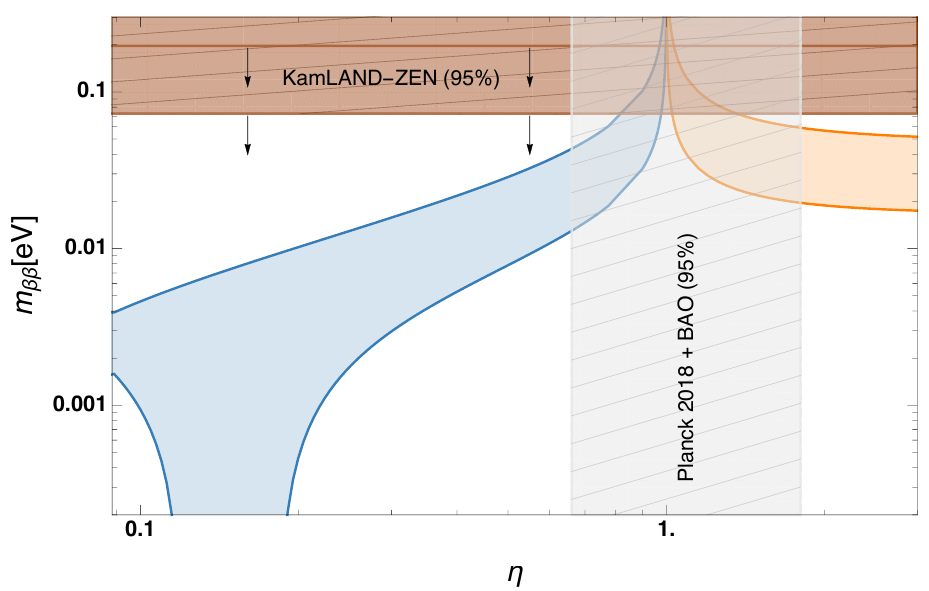
Figure 6 . E(cid:11)ective Majorana mass m (cid:12)(cid:12) as a function of (cid:17) , for normal (blue region) and inverted (orange region) ordering. The plot assumes (cid:17) > (cid:17) 0 , which implies (cid:17) (cid:21) 0 : 088 to satisfy constraints from oscillation experiments. The color code matches the one used in (cid:12)gures 2 and 1. The plot assumes the best-(cid:12)t values for the mixing angles and mass splittings. The width of the bands arises from varying the Majorana phases in [0 ; 2 (cid:25) ]. The brown hatched horizontal region corresponds to the 95% exclusion on m (cid:12)(cid:12) from KamLAND-Zen [33], assuming optimistic nuclear matrix elements. The solid line inside the brown region shows the relaxed upper limit obtained for pessimistic nuclear matrix elements. The grey hatched vertical band show the 95% excluded region for (cid:17) from our analysis of Planck 2018 + BAO data in this